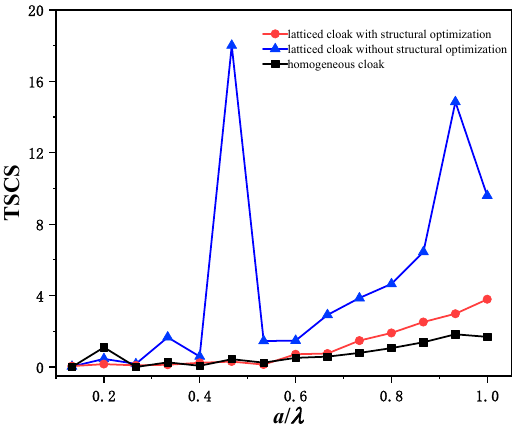
Table 2. Microstructure and homogenized property corresponding to each layer of PMs based on Figure 16. TSCS spectra of PM acoustic cloak with structural optimization. Figure 16. TSCS spectra of PM acoustic cloak with structural optimization. carbon fiber.